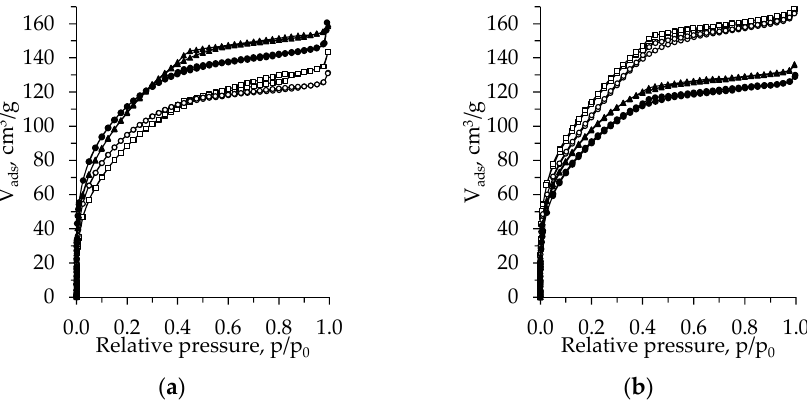
Figure 3. Isotherms of the subcritical dried (800 mbar, 70 °C, 8 h) TiO 2 aerogels (precursor TBOT) versus the type of exchange solvent ( ● —without exchange, ○ —nH, ▲ —CH, □ —DE) and ageing (without ( a ) and after ( b ) ageing).